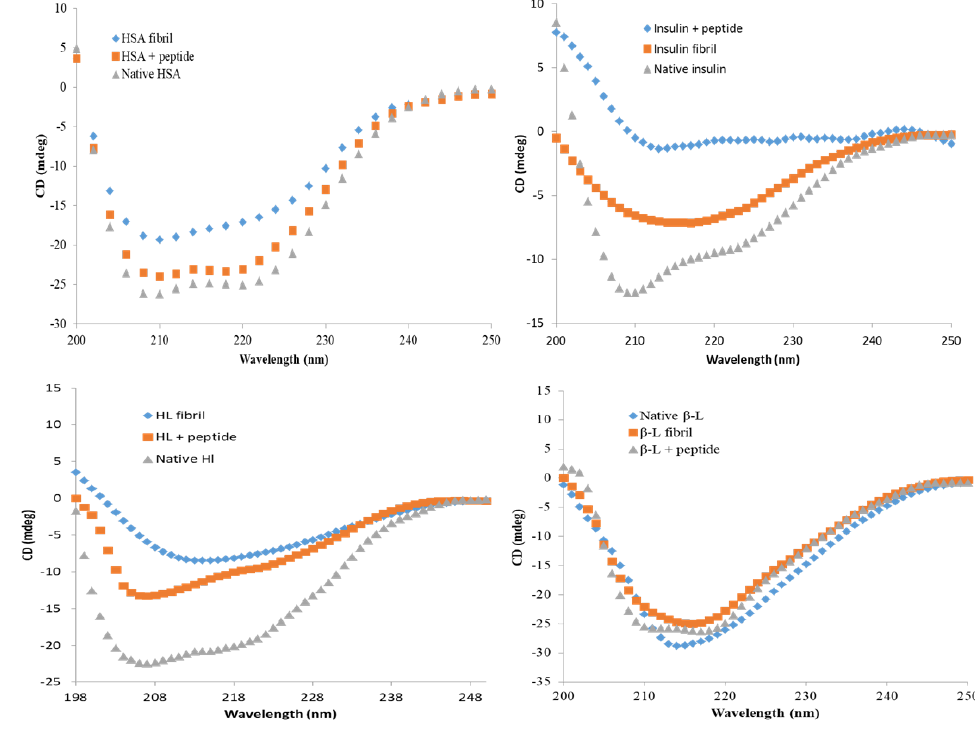
Figure 5. Far-UV CD spectra.